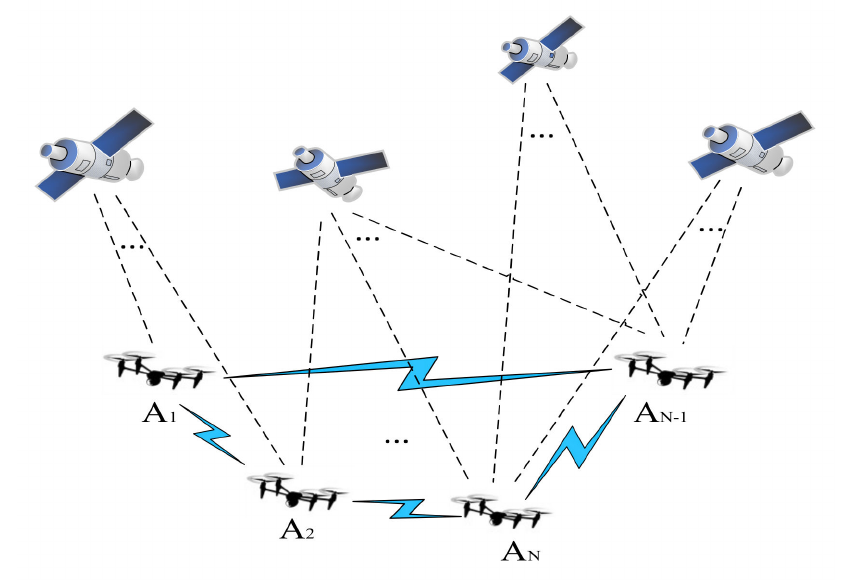
Figure 1. Cooperative positioning network of a UAV